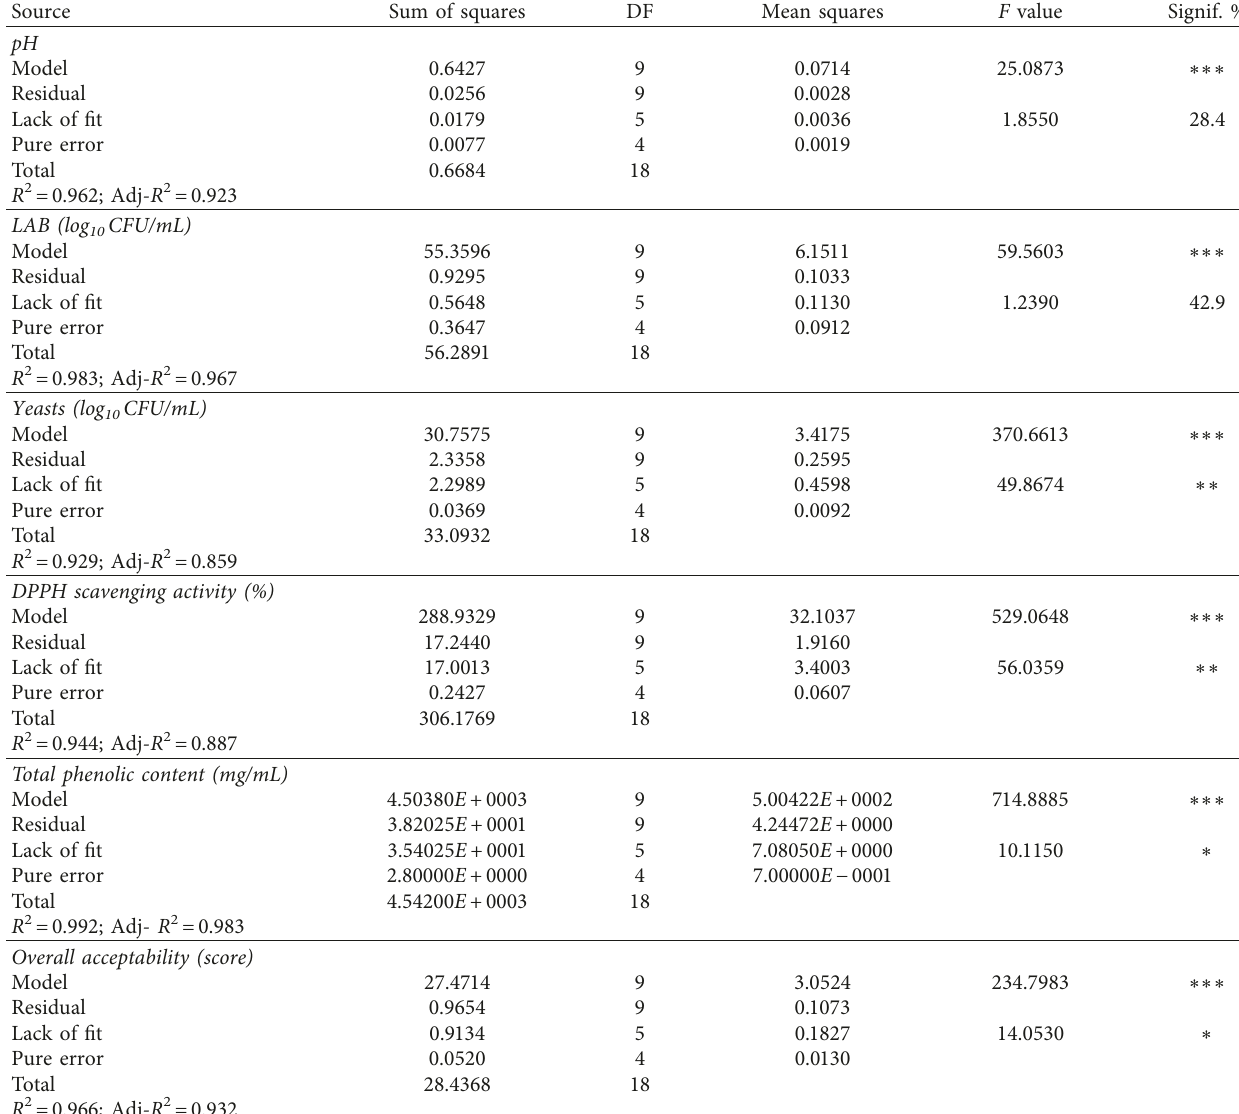
Table 5: Analysis of variance and regression